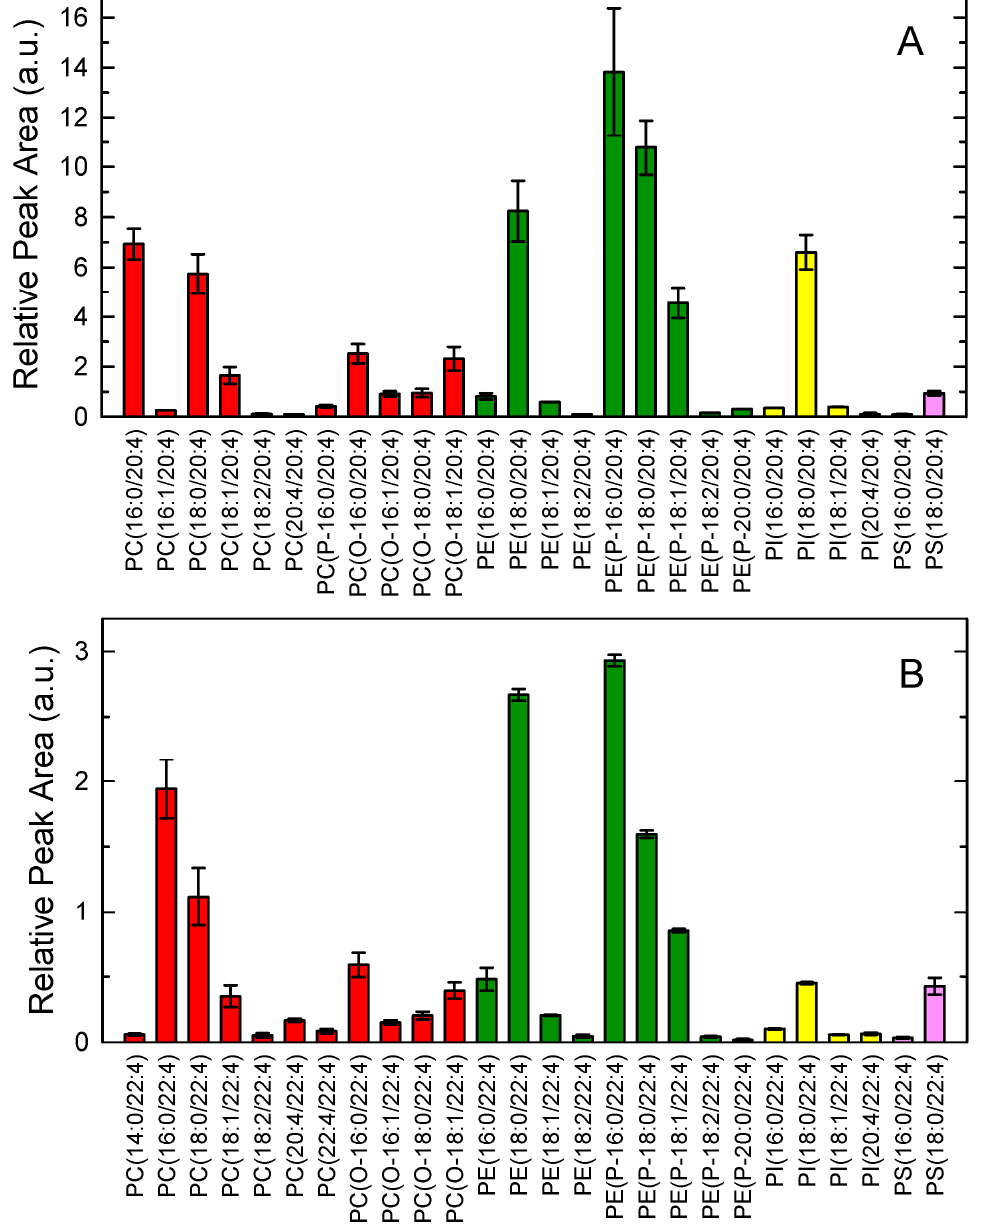
Figure 2. AA and AdA-containing phospholipid molecular species in peritoneal macrophages The profiles of AA- ( A ) or AdA- ( B ) containing PC (red), PE (green), PI (yellow), and PS (pink) species in peritoneal macrophages were determined by liquid chromatography/mass spectrometry (LC/MS). Fatty chains within the different phospholipid species are designated by their numbers of carbons and double bonds. A designation of O- before the first fatty chain indicates that the sn -1 position is ether linked, whereas a P- designation indicates a plasmalogen form ( sn -1 vinyl ether linkage) [47]. Phospholipids containing two ester bonds have no designation. Results are shown as mean values ± standard error of the mean ( n = 3).